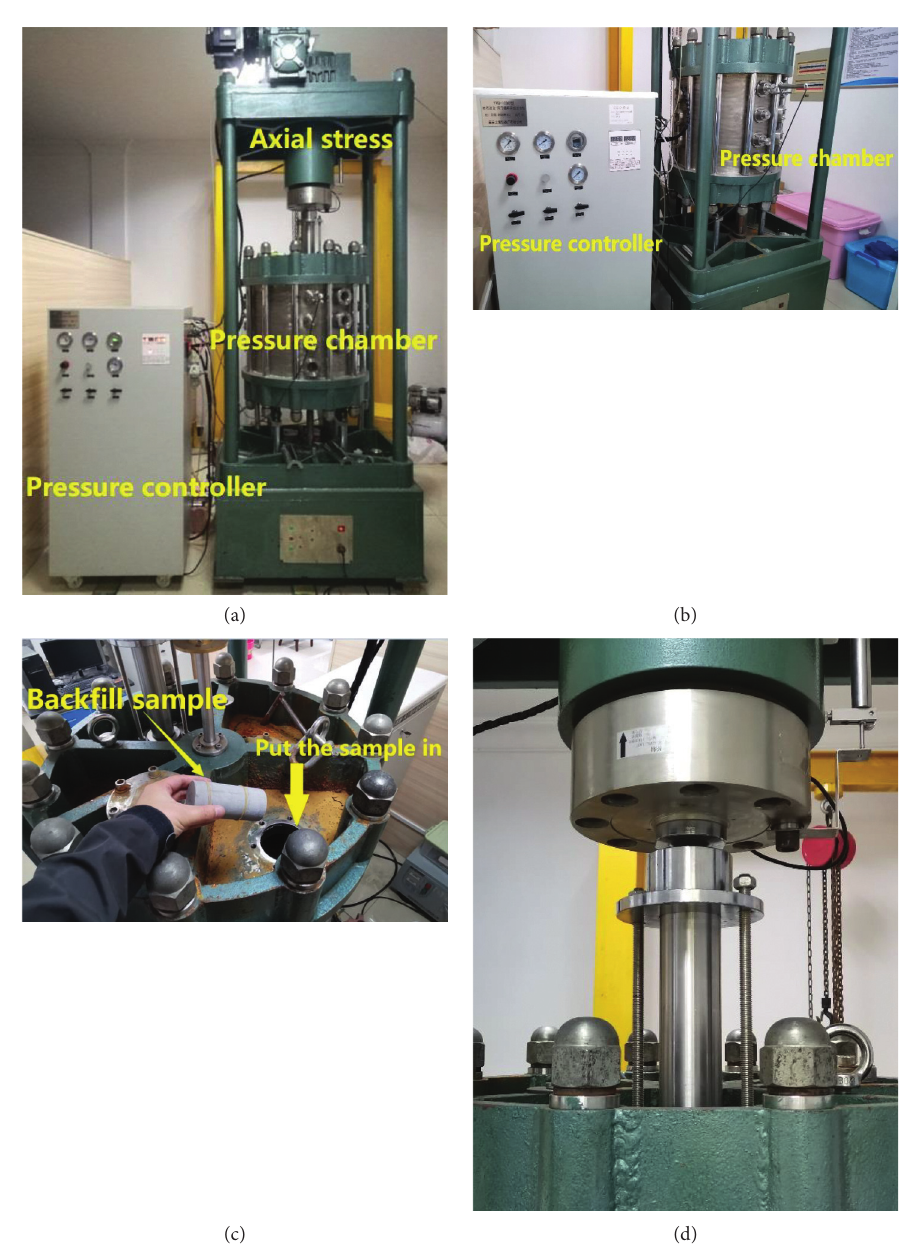
Figure 8: Equipment and operation details. (a) YRQ-1000 rock immersion-air-drying cyclic load rheometer. (b) YRQ-1000 rock im- mersion-air-drying cyclic load rheometer. (c) Putting the sample into the pressure chamber. (d) Axial